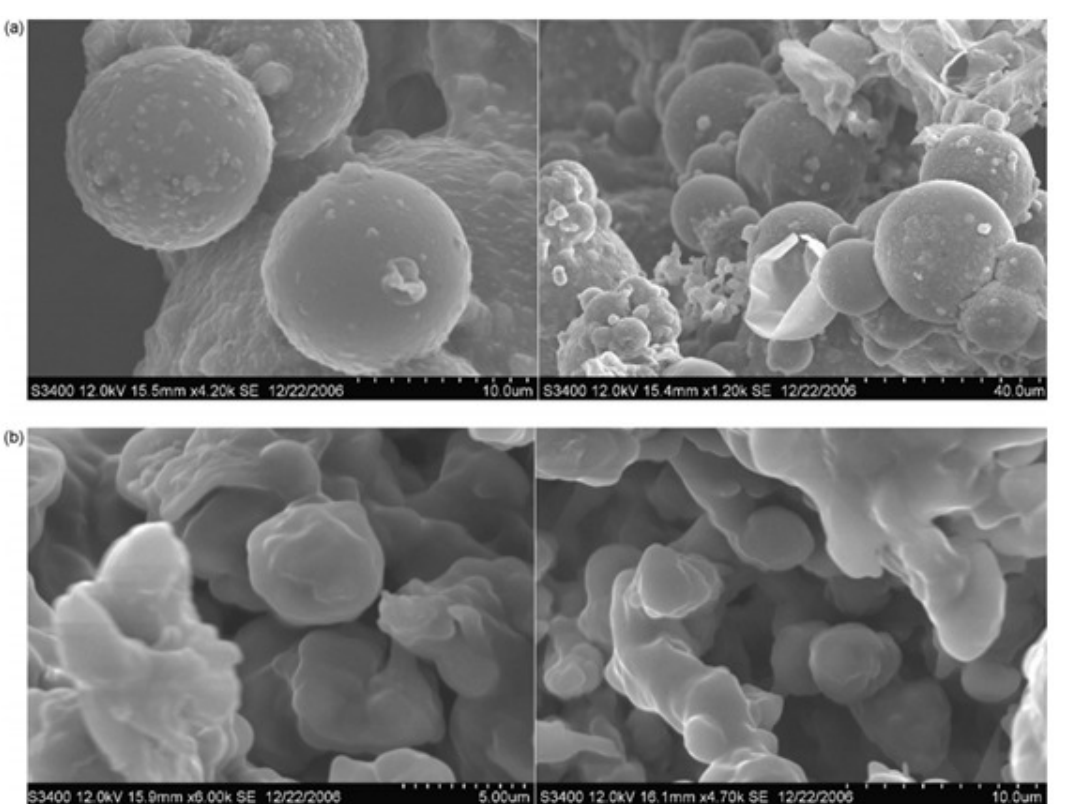
Figure 40. SEM pictures of the microcapsules formed using ( a ) SLS as surfactant and ( b ) Tween-85 as surfactant. From reference [62] .